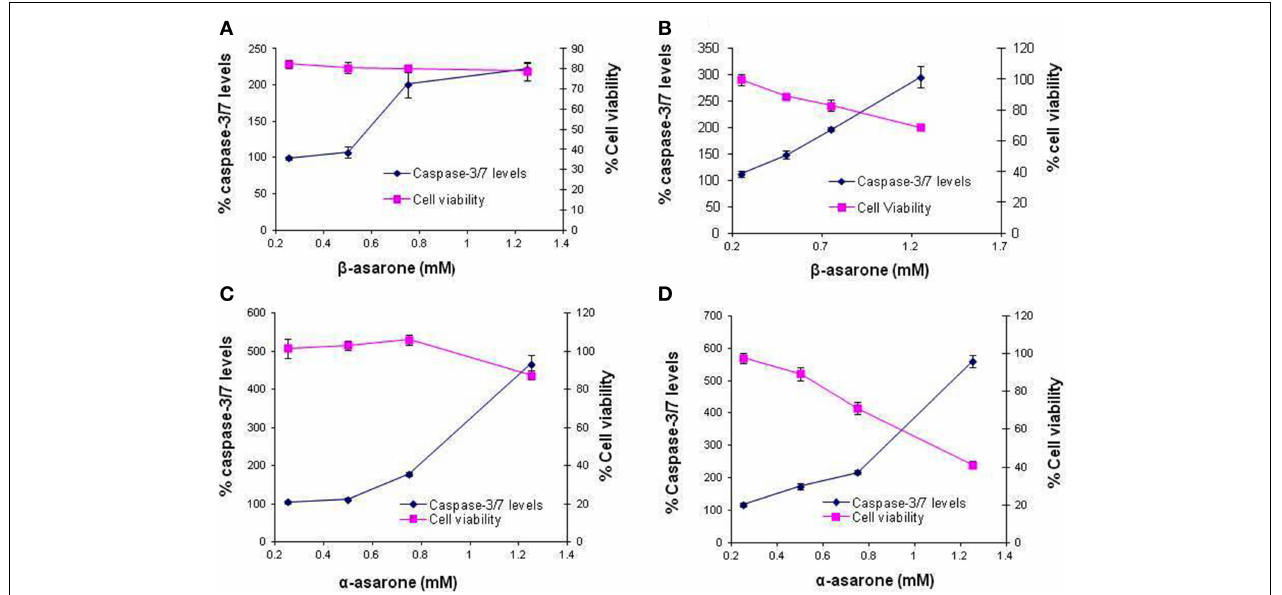
FIGURE 5 | Effects on caspase-3/7 activation and cell viability after treatment with (A) β -asarone for 6h, (B) β -asarone for 12h, (C) α -asarone for 6h and (D) α -asarone for 12h. The plot